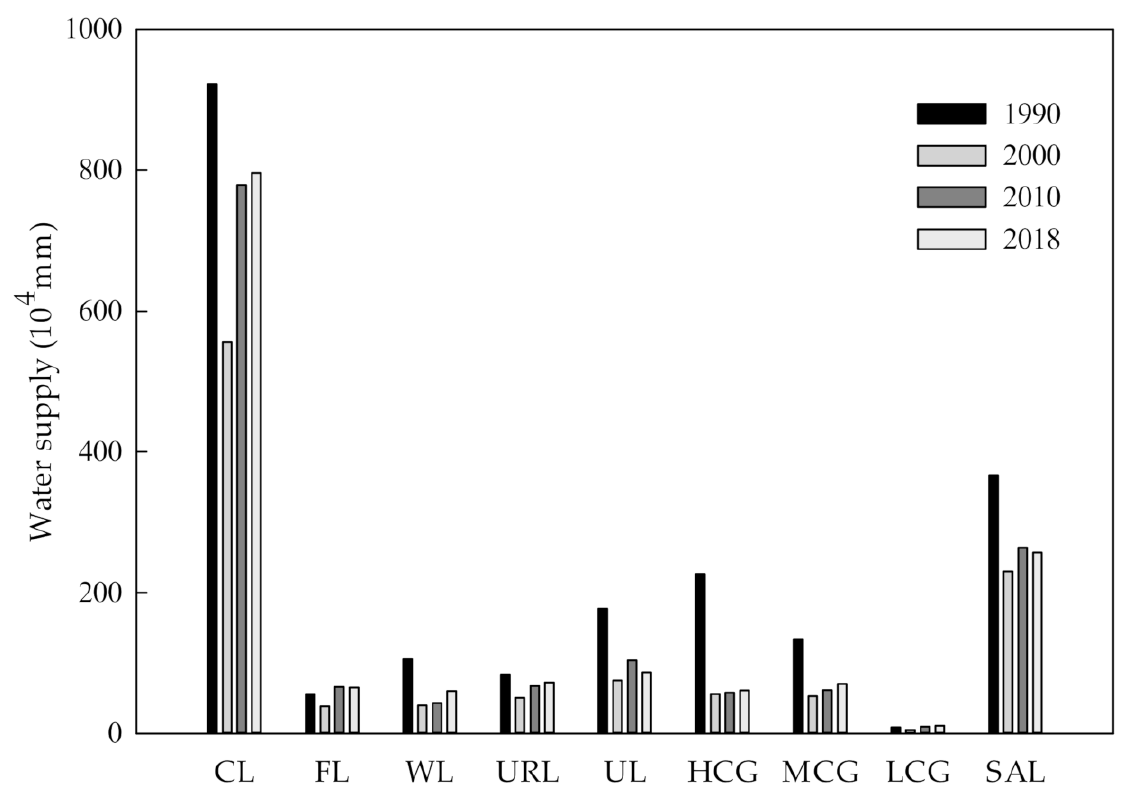
Figure 7. Total water supply of different land use types from 1990 to 2018. CL, Cultivated land; FL, Forest land; WL, Water land; URL, Urban and rural construction land; UL, Unused land; HCG, High- cover grassland; MCG, Medium-cover grassland; LCG, Low-cover grassland; SAL, Saline-alkali land.